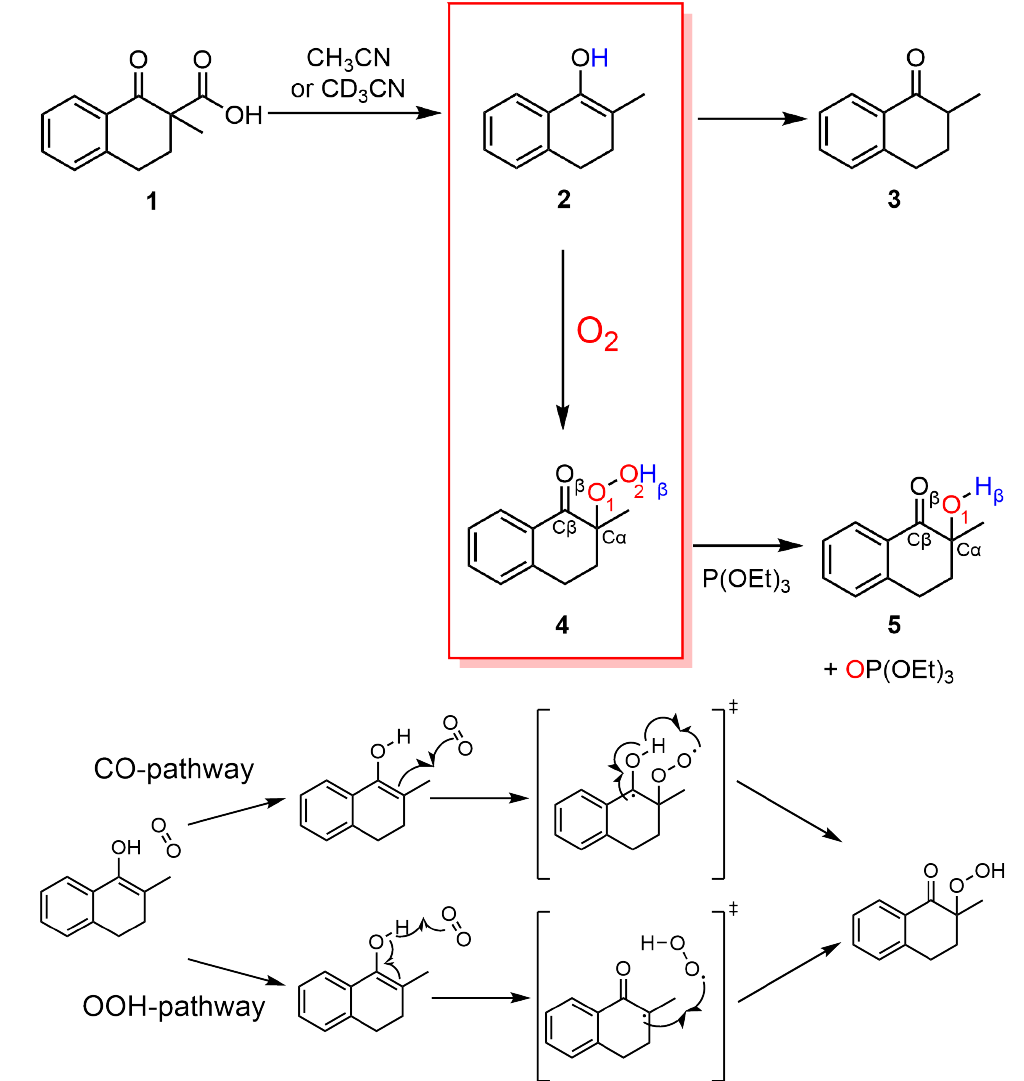
Figure 1. Top panel: Decarboxylation of 2-methyl-1-tetralone-2-carboxylic acid ( 1 ) involves the formation of an enol intermediate ( 2 ) [51]. This enol is affected by a side reaction with atmospheric oxygen to obtain the hydroperoxide tetralone-derivative ( 4 ). The reduction of ( 4 ) using P(OEt) 3 leads to the α -ketol ( 5 ). The transferred proton is colored in blue, and atoms are labeled according to the notation used in the article. Bottom panel: Possible reaction pathways for the peroxidation of the 2-methyl-3,4-dihydro-1-naphthol molecule. CO-pathway (upper path), where the C α -O1 bond is formed first, and then the peroxide is protonated, and the OOH-pathway, in which the protonation of O 2 occurs prior to the formation of the C α O1